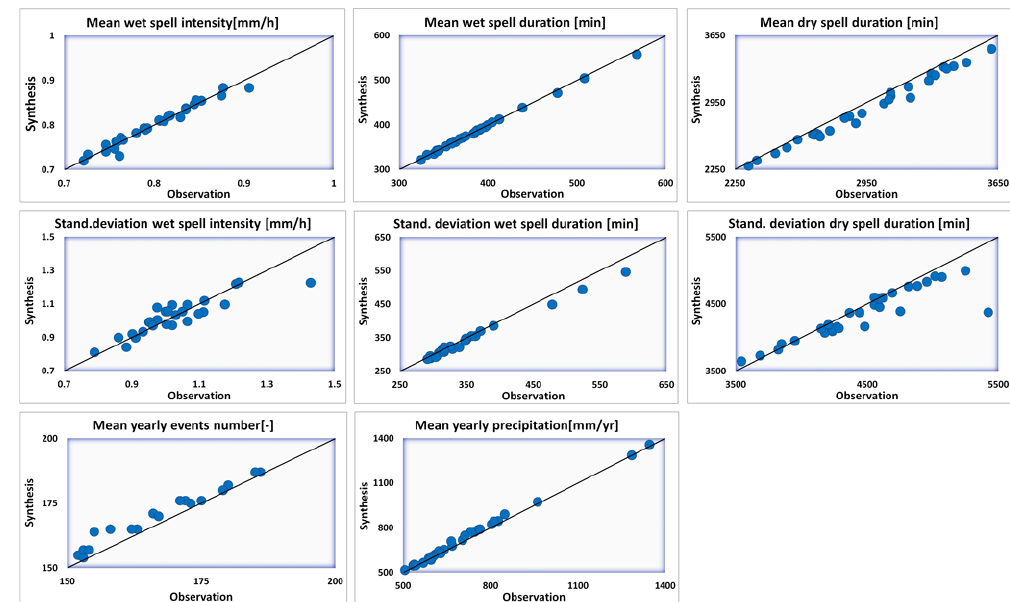
Fig. 4. Scatter-plots of statistical moments of observed (9–15yr) vs. synthetic (1000yr, CP-conditioned model) rainfall time series.